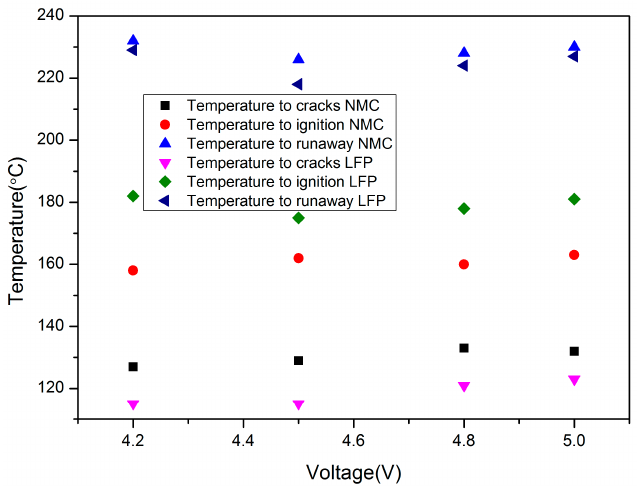
Figure 9. Some critical temperatures of LIB in tests.